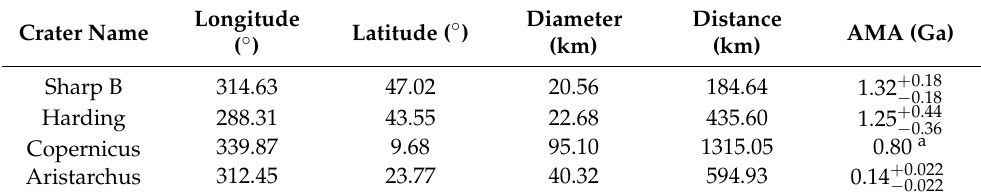
Table 3. The location and AMA of external craters younger than the CE-5 landing